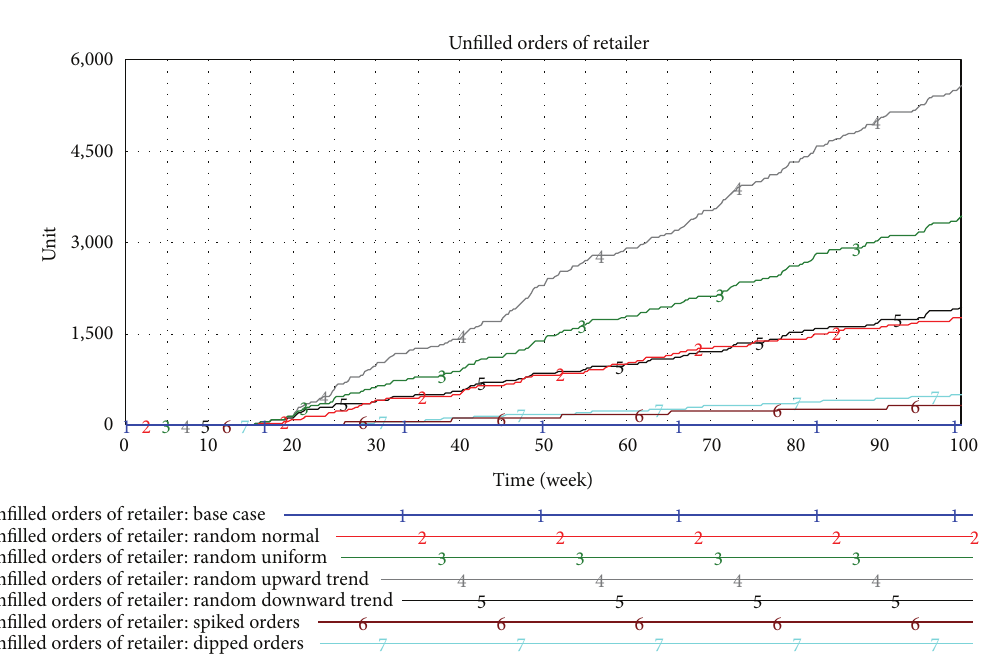
Figure 4: Unfilled Orders at retailer despite information